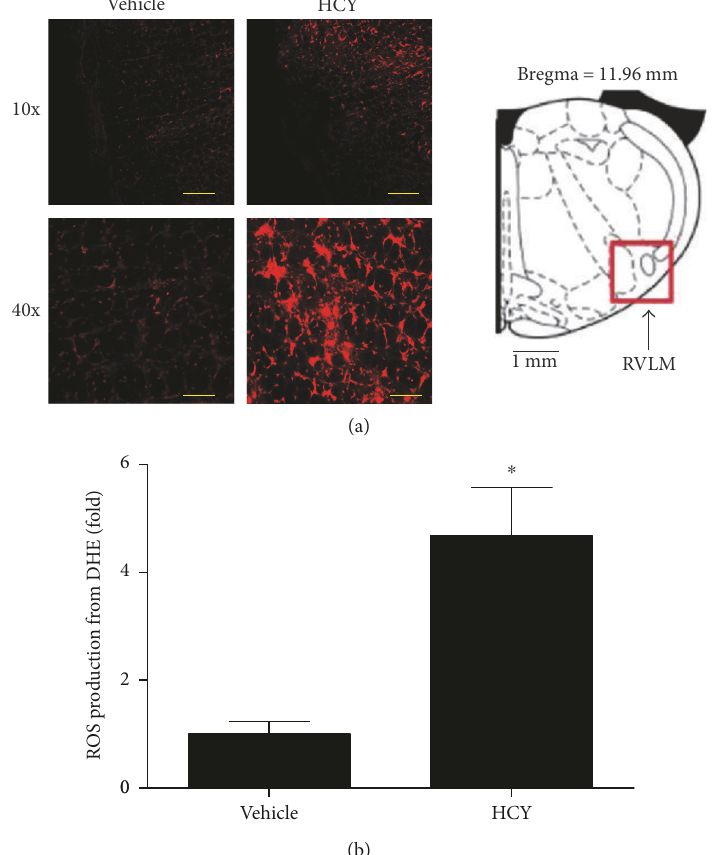
Figure 3: The ROS production in the RVLM in response to systemic HCY. (a) Representative images of ROS (red) by the DHE method in the RVLM region (right). Scale bars =200 μ m in 10x magni fi cation and 50 μ m in 40x magni fi cation. (b) Quanti fi cation of ROS production in the RVLM. n = 5 /group. ∗ P < 0 05 versus the vehicle